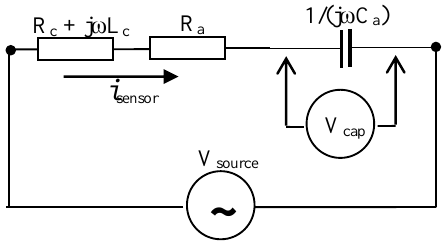
Figure 2. The electrical equivalent circuit of the ECT sensor for reinforcement inspections.